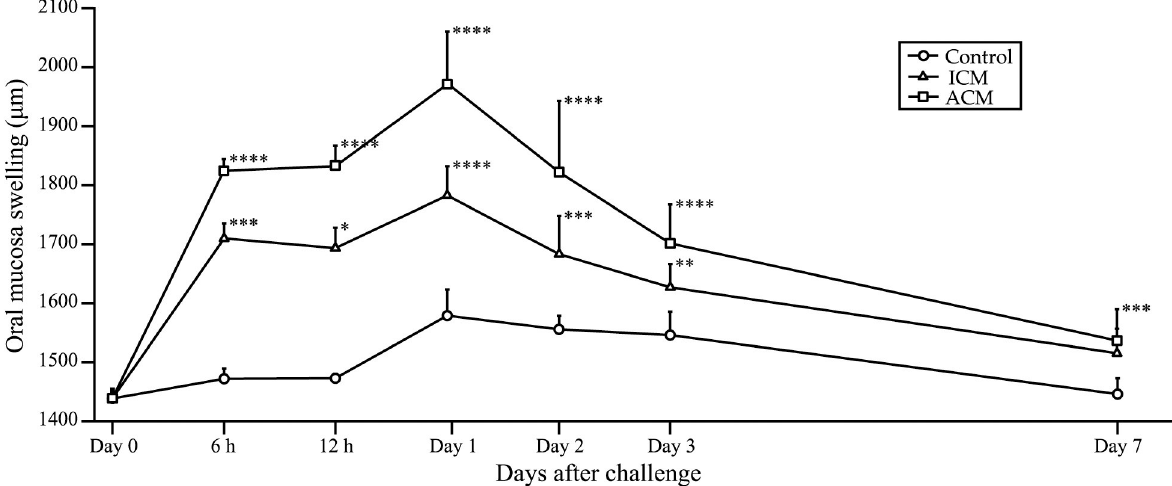
Fig 1. Swelling of the oral mucosa in Ni-induced allergic mice. Buccal area swelling from 6 h to day 7 after challenge was significantly higher in ACM mice compared with control and ICM mice. Bars and error bars indicate mean plus standard deviation. Statistical significance was tested by Dunn’s test ( � p < 0.05, �� p < 0.01, ��� p < 0.001, ���� p < 0.0001).